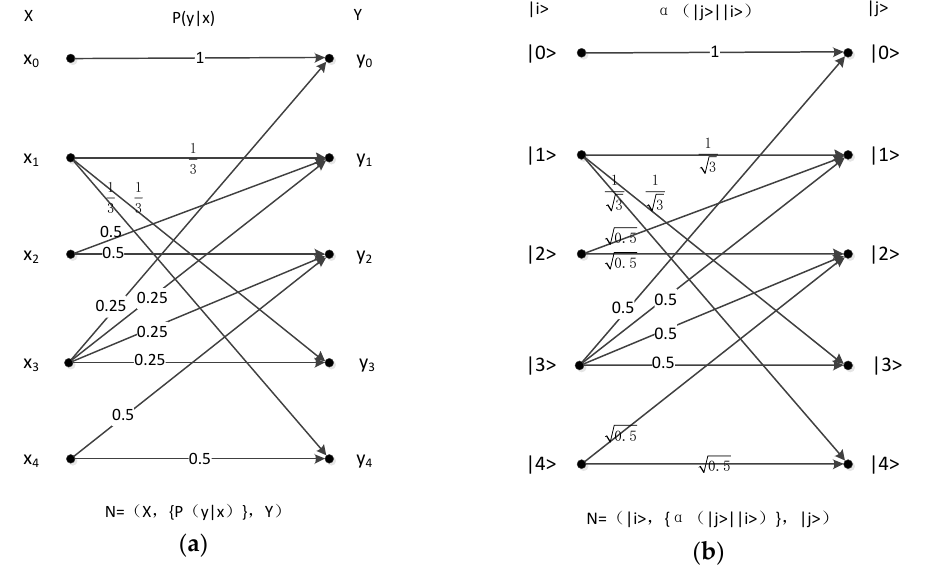
Figure 7. ( a ) Classical five-symbol multilateral obfuscation channel; ( b ) quantum five-symbol multilateral obfuscation channel.